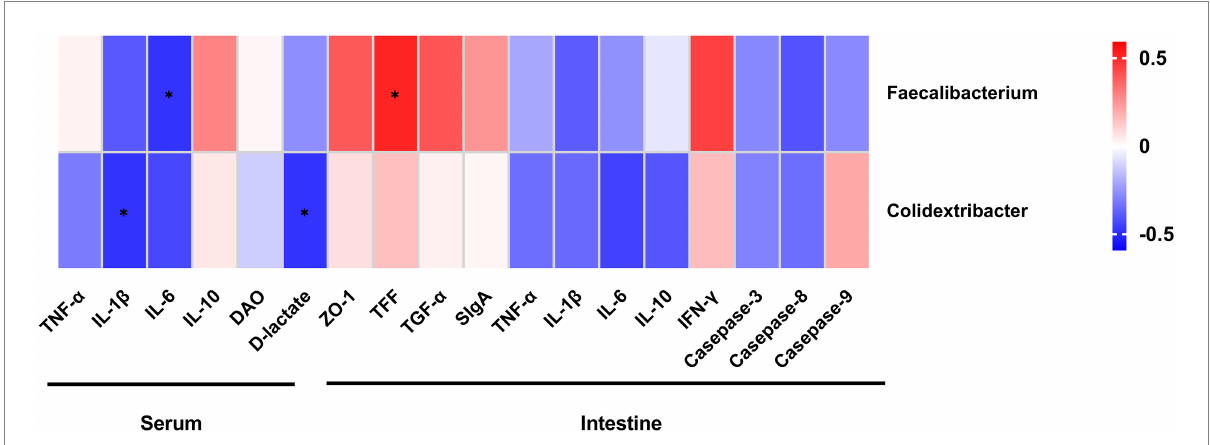
FIGURE 13 Spearman’s correlation analysis between differential bacterial abundances and concentrations of metabolic parameters and immunological markers in serum and intestine. Tumor necrosis factor- α (TNF- α ); Interleukin-1 β (IL-1 β ); Interleukin-6 (IL-6); Interleukin-10 (IL-10); zonula occludens-1 (ZO-1); Trefoil peptides (TFF); Transforming growth factor alpha (TGF- α ); Secretory immunoglobulin A (SIgA); and Interferon- γ (IFN- γ ). * The correlation is significant at a level of